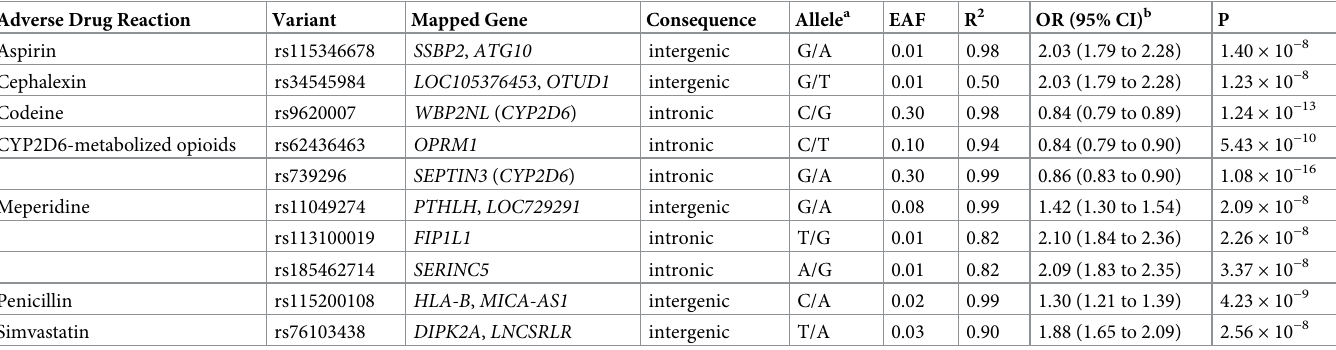
Table 3. Lead variant per signal associated with adverse drug reactions for European ancestry patients. Adverse Drug Reaction